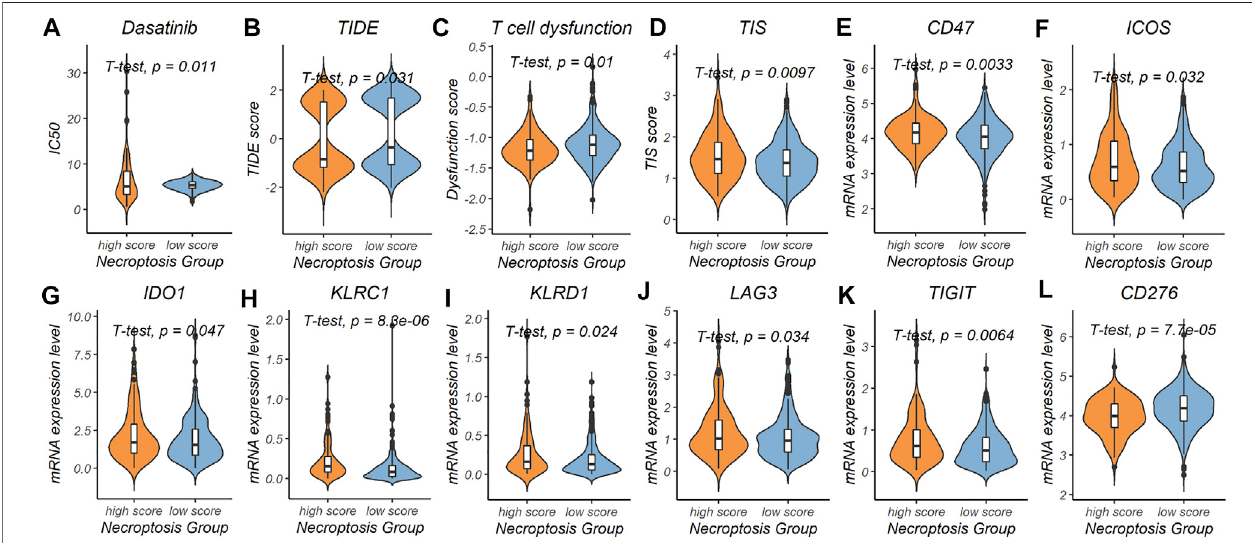
FIGURE 6 | Predictive power of the necroptosis gene signature in chemotherapy and immunotherapy response. (A) Prediction of IC50 for dasatinib in the high- necroptosis score and low-necroptosis score group. (B – D) Comparison of tumor immune dysfunction and exclusion (TIDE) score, T cell dysfunction score and tumor in fl ammation signature (TIS) score between the high-necroptosis score and low-necroptosis score group. (E-L) mRNA expression level differences of immunotherapy related genes (CD47, ICOS, IDO1, KLRC1, KLRD1, LAG3, TIGIT, and CD276) between the high-necroptosis score and low-necroptosis score group.